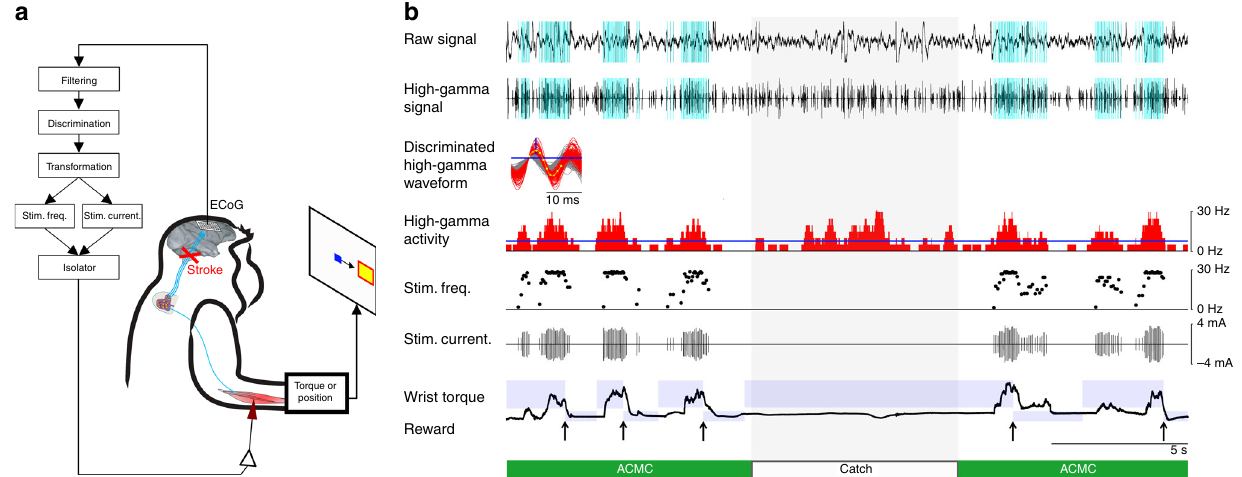
Fig. 1 Volitional control of a paralysed hand via an arti fi cial cortico-muscular connection. a Each monkey controlled the position of a cursor (blue square) using wrist torque or hand position to acquired targets (red square) displayed on the screen. An arti fi cial cortico-muscular connection (ACMC) was achieved by converting cortical oscillatory activity in real time to electrical stimulation of paralysed muscles. b A example of fi ve successful trials from a torque-tracking task when the ACMC was on (green) and one catch trial when the ACMC was switched off (grey shading) in Monkey TA. Extensor and centre wrist torque targets (blue shading) were presented on the screen. The input microelectrode was located in the hand area of the primary motor cortex (M1), and electrical stimuli were applied to the extensor carpi radialis (ECR) and extensor digitorum communis (EDC) muscle pair. A raw signal (1st row) was recorded from the electrode in M1 and fi ltered in the high-gamma frequency band (2nd row). The blue vertical lines in the 1st and 2nd rows indicate the timing of electrical stimulation. An arbitrary one-cycle high-gamma waveform was selected (3rd row) from the high-gamma oscillations as the input signal for controlling the ACMC. The red traces in the 3rd row indicate the high-gamma waveforms detected by the template-matching method, with the thresholds represented as blue lines in the 3rd row. The yellow lines with 10 yellow dots in the 3rd row represent the template for high-gamma waveform detection. The 4th row indicates the frequencies of the detected high-gamma waveforms. Electrical stimulation was delivered to the paralysed ECR and EDC muscles with a current (5th trace) and frequency (6th trace) that were proportional to the moving averaged frequencies (250-ms time window) of the detected high-gamma waveforms above a stimulation threshold (blue line in the 4th trace). The blue rectangles in the wrist torque trace in the 7th row represent the extensor and centre wrist torque targets. The arrows at the bottom indicate successful trial completion and reward times. Similar results were obtained from independent experiments ( N = 3 monkeys, n = 108 F (9,916) = 18.82, P = 5.11 × 10 − 29 . Black and red asterisks indicate